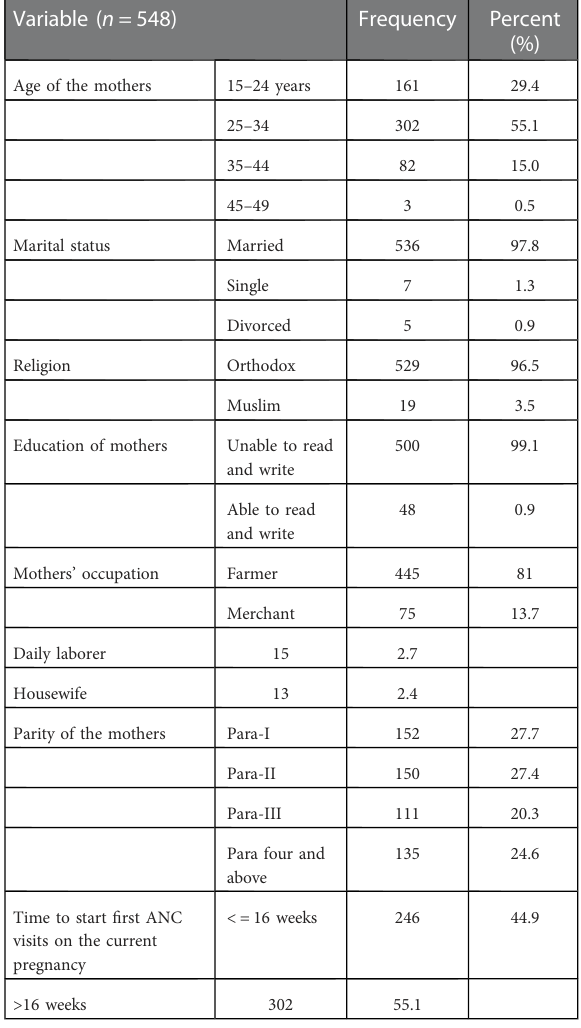
TABLE 1 Socio-demographic characteristics of the respondents on maternal waiting home utilization, east gojjam,